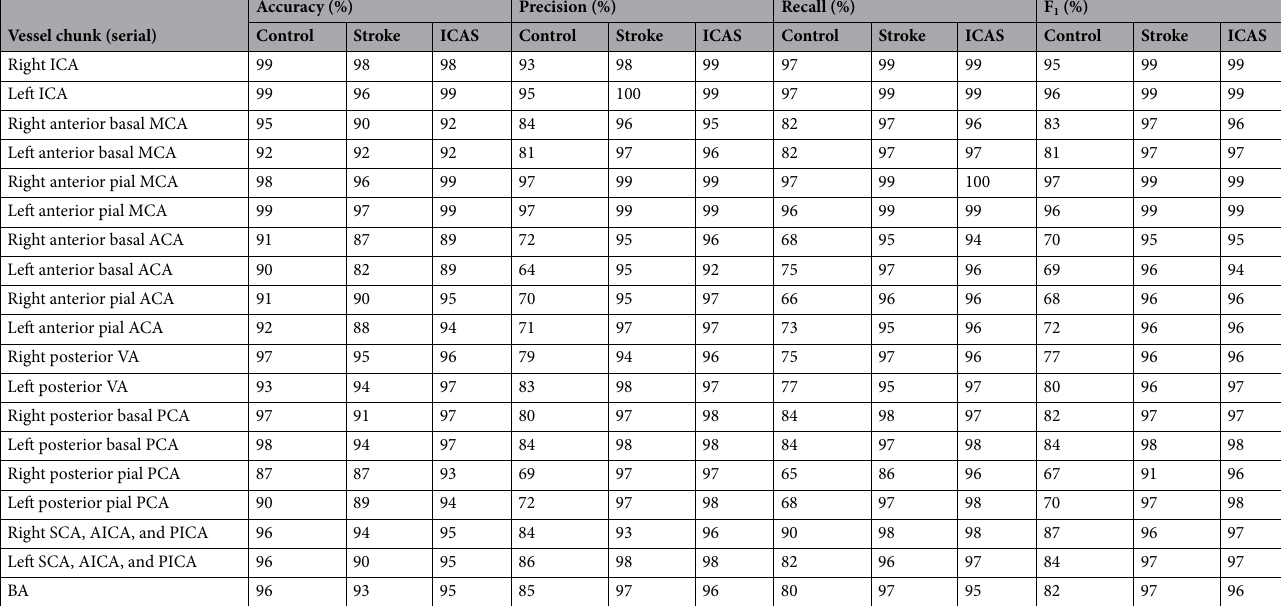
Table 1. Vessel brancompartmentalisationion into a 20-chunk macrovessel framework composed of 62 major arterial segments delineated the whole cohort-wise performance range of vessel chunks and segments. a Each unit of major arterial segments was further condensed and tagged with identifiers composed of chunk and segment digits. b Symmetrical properties of entire cerebrovascular branches were prefixed with ‘Right’ or ‘Left’; abbreviations are defined in the text. c If the sample size was too small for inclusion in the test pool or there was only one type of branch within the chunk, the performance profile of the vessel branch was excluded. ICA, internal carotid arteries; OA, ophthalmic arteries; ACHA, anterior choroidal arteries; VA, vertebral arteries; PICA, posterior inferior cerebellar arteries; AICA, anterior inferior cerebellar arteries; IAA, internal auditory arteries; SCA, superior cerebellar arteries; PCOA, posterior communicating arteries; PCA, posterior cerebral arteries; P1, pre-communicating PCA; P2, post-communicating PCA; P1P2, coalescence among P1 and P2; P3P4, mixture of quadrigeminal and calcarine PCA; PO, parieto-occipital arteries; PCALC, calcarine arteries; PPA, direct peduncular perforating arteries; HA, hippocampal arteries; PCAAT, anterior temporal PCA; PCAPT, posterior temporal PCA; PCALP, lateral posterior choroidal arteries; M1, sphenoidal middle cerebral artery; MCA, middle cerebral arteries; MCAS, superior division of MCA; MCAI, inferior division of MCA; MCALO, lateral orbitofrontal arteries; MCAPR, pre-Rolandic MCA; MCAR, Rolandic MCA; MCAAP, anterior parietal MCA; MCAPP, posterior parietal MCA; MCAA, angular MCA; MCAPT, posterior temporal MCA; MCAMT, middle temporal MCA; MCAAT, anterior temporal MCA; MCAPF, pre-frontal MCA; ACA, anterior cerebral arteries; A1, horizontal pre-communicating ACA; A2, vertical post-communicating pre-callosal ACA; A1A2, combination of A1 and A2; ACAMO, medial orbitofrontal ACA; A2F, frontopolar vertical post- communicating pre-callosal ACA; ACAC, callosomarginal ACA; ACAP, pericallosal ACA; BA, basilar artery; ACOA, anterior communicating